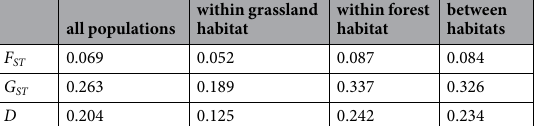
Table 3. Different parameters for pairwise genetic differentiation given for the two habitats. Values for all genetic differentiation parameters between populations of different habitats were significantly different from values between populations of the same habitat as reported in the ANOVA-like mantel test (P < 0.01). Genetic differentiation was also significantly greater amonulations within the forest habitat than between grassland populations for all parameters (P < 0.001).